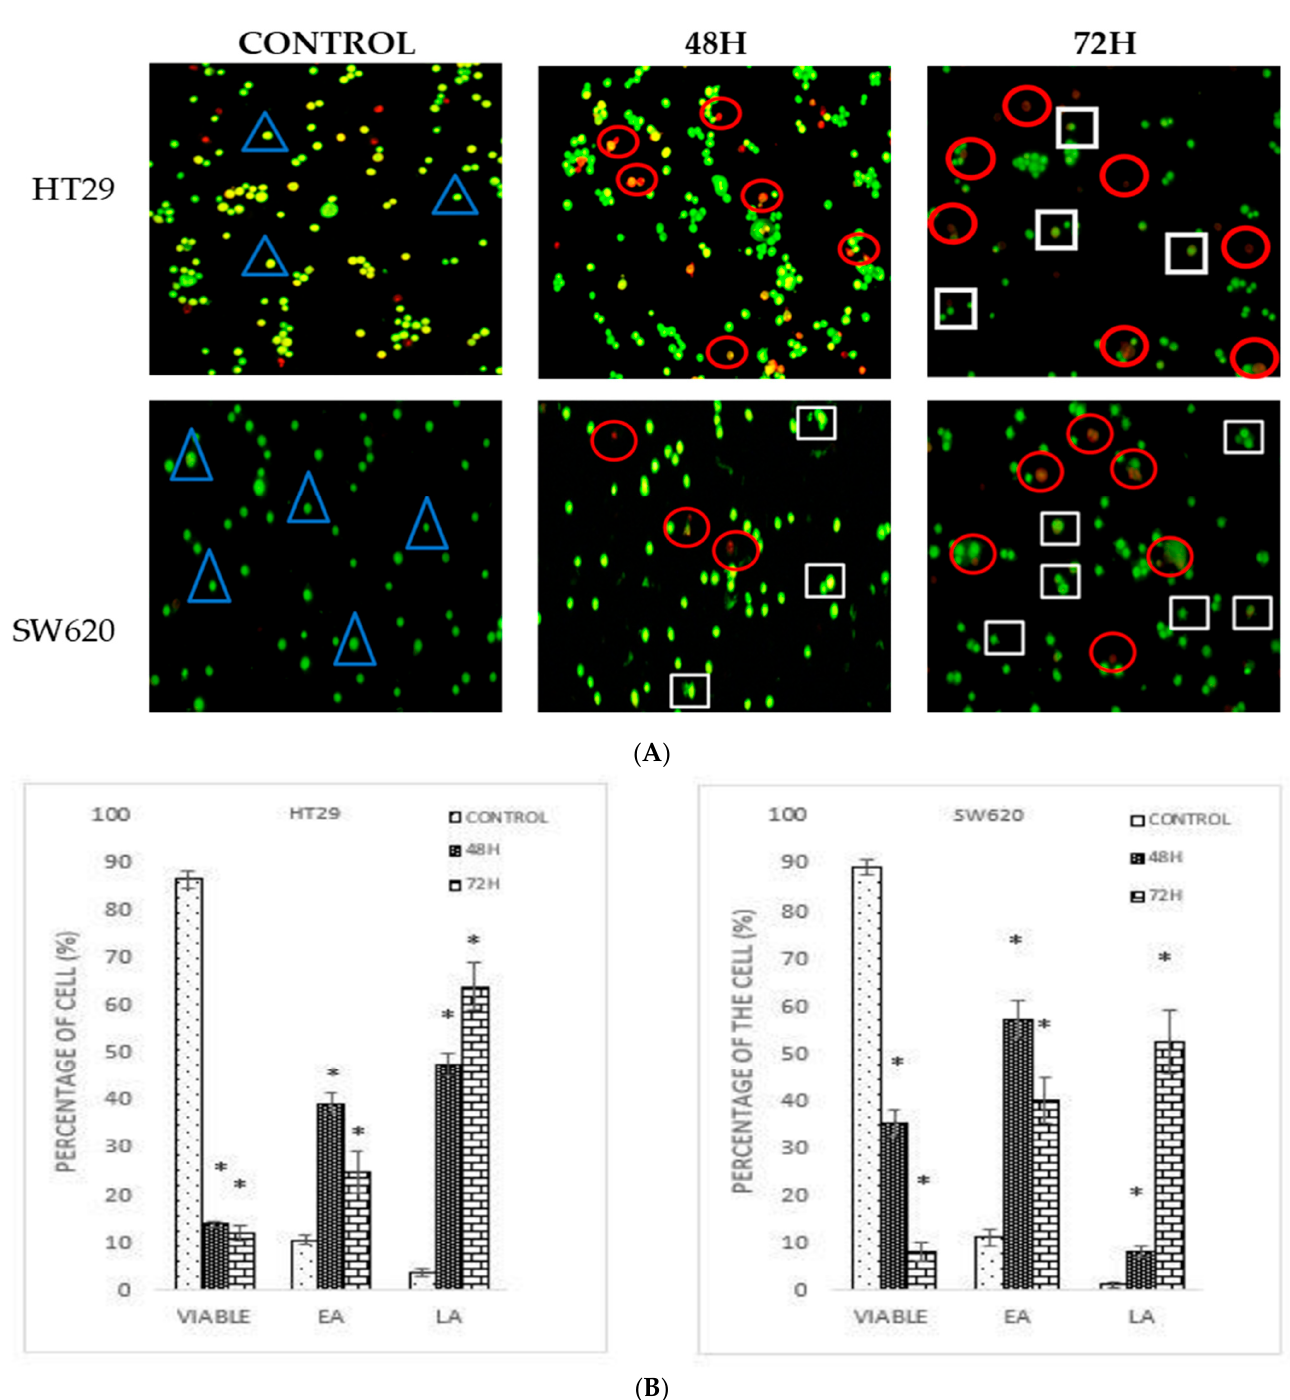
Figure 2. ( A ) Morphological changes in HT29 and SW620 after 48 h and 72 h treatment with DMCH. ( B ) Quantification analysis of HT29 and SW620 based on the cell uptake of acridine orange and propidium iodide (blue triangle: viable; white square: early apoptosis; red circle: late apoptosis/necrosis). EA (early apoptosis), LA (late apoptosis). All data are expressed as mean ± standard error mean (S.E.M.). * p < 0.05 compared with the corresponding controls.